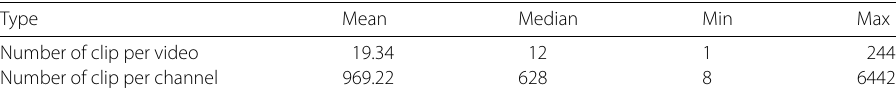
Table 5 Descriptive statistics of balanced dataset ( N video = 10,068, N channel = 201) Type